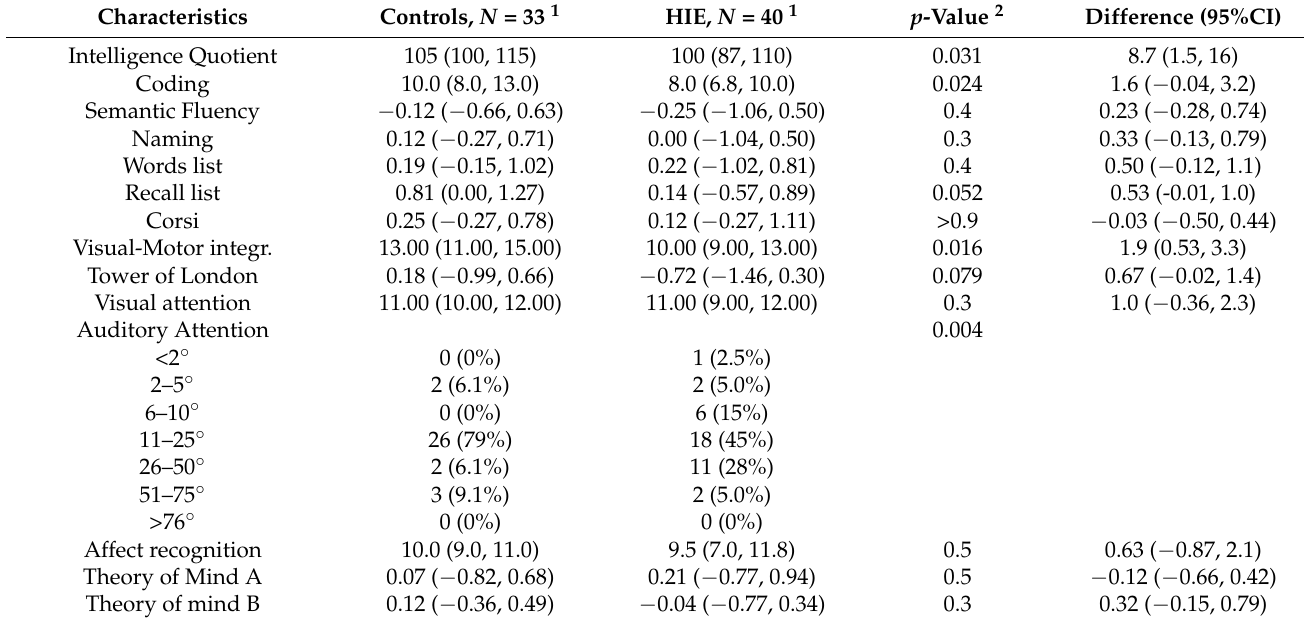
Table 1. Group characteristics by neuropsychological tests.